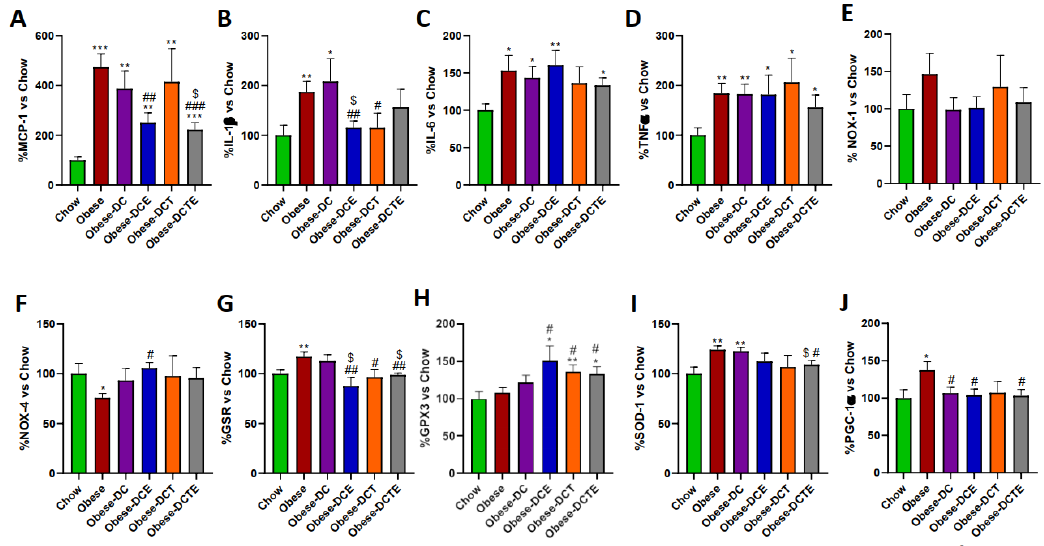
Figure 5. Gene expression of Monocyte Chemotactic Protein-1 ( A ), Interleukin 1 β ( B ), Interleukin 6 ( C ), Tumor Necrosis Factor α ( D ) NADPH oxidase 1 ( E ), NADPH oxidase 4 ( F ), Glutathione Reductase ( G ), Glutathione Peroxidase 3 ( H ), Super Oxide Dismutase 1 ( I ) and PPAR- γ coactivator 1 α ( J ) in gastrocnemius muscle. Chow = mice fed a standard diet for 25 weeks; Obese = mice fed a high fat (60% kcal from fat)/high sucrose diet for 25 weeks; DC = mice fed a high fat (60% kcal from fat)/high sucrose diet for 23 weeks and switched to a diet with lower caloric intake (25% kcal from fat) for two weeks; DCE = mice fed a high fat (60% kcal from fat)/high sucrose diet for 23 weeks and switched to a diet with lower caloric intake (25% kcal from fat) supplemented with CSAT+ ® for two weeks; DCT = mice fed a high fat (60% kcal from fat)/high sucrose diet for 23 weeks and switched to a diet with lower caloric intake (25% kcal from fat) and subjected to aerobic training for two weeks; DCTE = mice fed a high fat (60% kcal from fat)/high sucrose diet for 23 weeks and switched to a diet with lower caloric intake (25% kcal from fat) supplemented with CSAT+ ® and subjected to aerobic training for two weeks. Values are represented as mean ± SEM; n = 8–10 mice/group. * p < 0.05 vs. chow; ** p < 0.01 vs. chow; *** p < 0.001 vs. chow; # p < 0.05 vs. obese; ## p < 0.01 vs. obese; ### p < 0.001 vs. obese; $ p < 0.05 vs. obese-DC. 3.8. Adipocyte Area and Gene Expression of Pro-Inflammatory and Oxidative Stress Related Markers in Retroperitoneal Adipose Tissue All treatments equally prevented the obesity-induced increase in the adipocyte area (Figure 6; p < 0.05) and in the mRNA levels of MCP-1 (Figure 7A; p < 0.001 for all) and IL- 6 (Figure 7C; p < 0.01 for all) in retroperitoneal adipose tissue. However only DCTE sig- nificantly reduced the gene expression of IL-1 β ( p < 0.05). Moreover, only obese mice sub- jected to DC and supplemented with CSAT+ ® , either alone or together with training, showed increased expression of GPX-3 and PGC-1 α ( p < 0.05 for both).